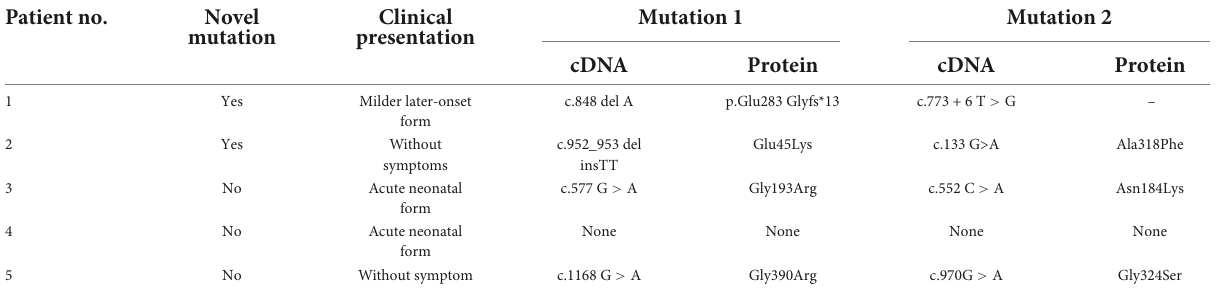
TABLE 2 Gene mutations characteristics of the five patients. Patient no.